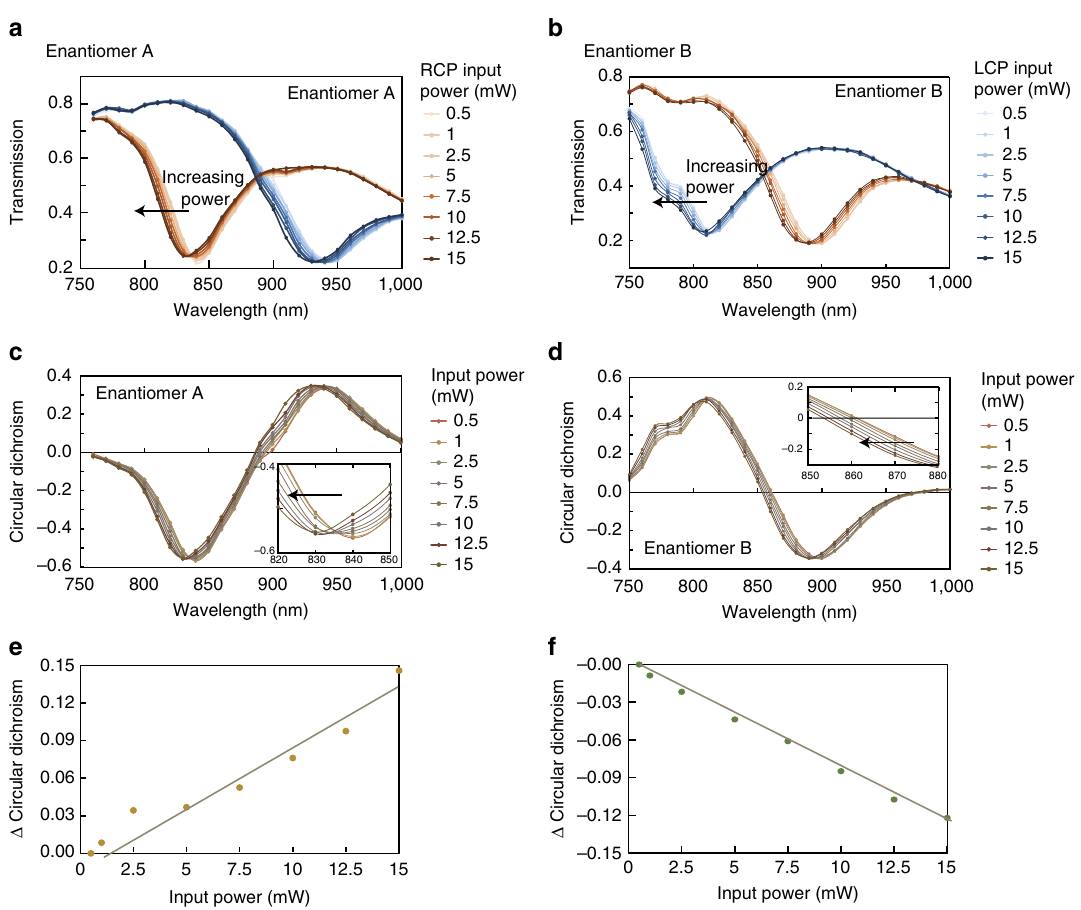
Figure 4 | Intensity-dependent circular dichroism. ( a , b ) Transmission spectra of enantiomers A and B when subjected to varied intensities of right and left circularly polarized light. As incident intensities are increased, the spectra of the resonances are blue shifted. This follows that the cross points and resonance dips are also shifted, implying that the corresponding optical rotation at higher intensities will also be effected. ( c , d ) Circular dichroic response of enantiomers A and B as a function of input intensity. The spectral shift for the resonance is B 10nm for the two enantiomers as shown in the inset of c , d , where the arrows show an increase in power. ( e , f ) Change in circular dichroism as a function of input power for the two enantiomers. The solid line acts as a guide for the eye. A change in circular dichroism of B 0.14 is demonstrated for a difference in power of 14.5mW. Average excitation power of 1mW corresponds to a peak intensity of 6 (cid:2) 10 7 Wcm (cid:3) 2